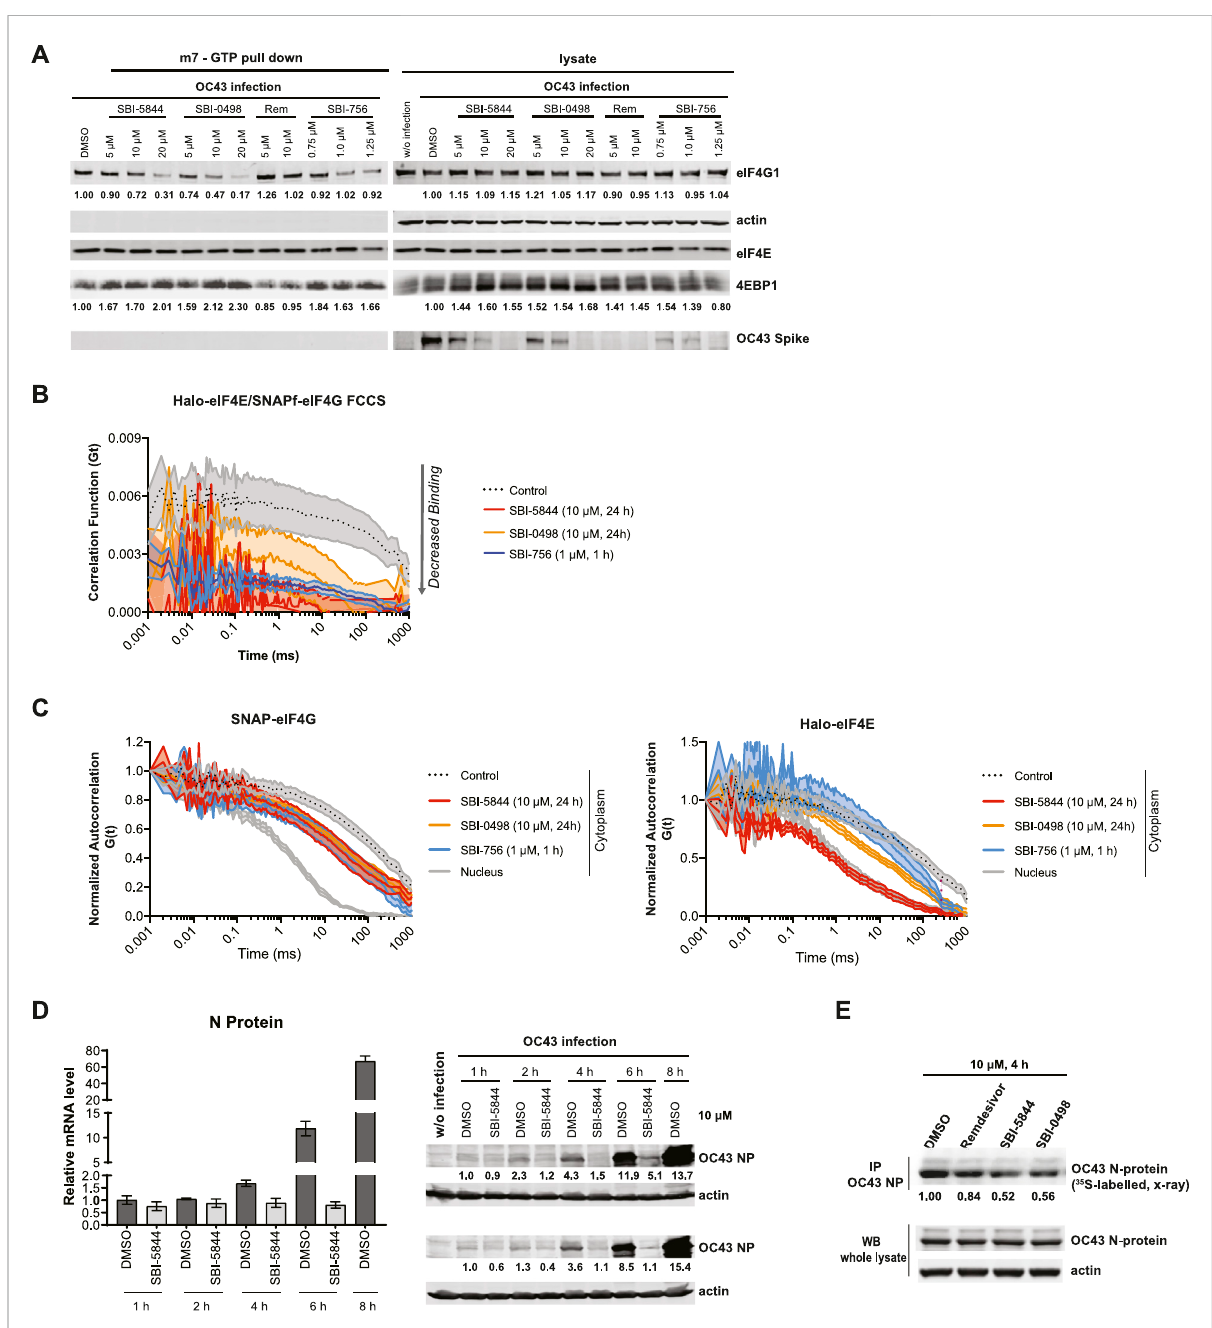
SBI-5844 and SBI-0498 attenuates translation initiation complex function. (A) Western blot analysis of indicated proteins prepared from A549 cells infected with OC43 and treated with indicated compounds. Cell lysates were incubated with m7GTP-agarose beads to capture the eIF4F complex. Showniswestern blotofboth totalcelllysates (right panel)and m7GTP-agarose bound proteins (leftpanel) immunoblotted withindicated antibodies. Each protein band was quanti fi ed by ImageJ, normalized to actin (right panel) or eIF4E (left panel) as indicated. (B) Simultaneous diffusion of endogenous JF585Halo-eIF4E and JF646SNAPf-eIF4G1 throughout the focal volume was analyzed in living cells by dual color cross- correlation spectroscopy in the indicated conditions (Mean ± SEM; N = 10). Cross-correlation, due to eIF4F:eIF4G interaction, was detected in the cytoplasm of cells treated with vehicle control. Minimal cross-correlation was detected upon treatment with SBI-756, SBI-5844 or SBI-0498. (C) Diffusion of endogenous JF646SNAPf-eIF4G1 (left panel) and JF585Halo-eIF4E (right panel) was measured by fl uorescence correlation spectroscopy in living cells treated with vehicle control or indicated compounds, in the indicated cellular compartment (Mean ± SEM; N = 10). Nuclear temporal autocorrelation depicts diffusion of free-diffusing JF646SNAPf-eIF4G1 (upper panel) and JF585Halo-eIF4E (lower panel). The autocorrelation curves were normalized for visual comparison of shape. (D) Vero E6 cells were infected with OC43 and treated with SBI-5844 for indicatedtimes.RNAandproteinwereextracted andsubjectedtoRT-qPCRanalysisfor virusRNA(left,mean±SD,n=3) andWBfor